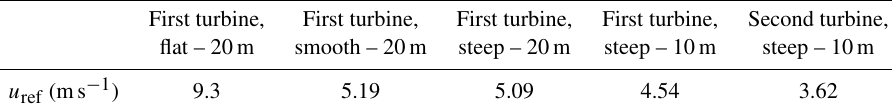
Table 2. Reference velocities at hub height used for different cases.